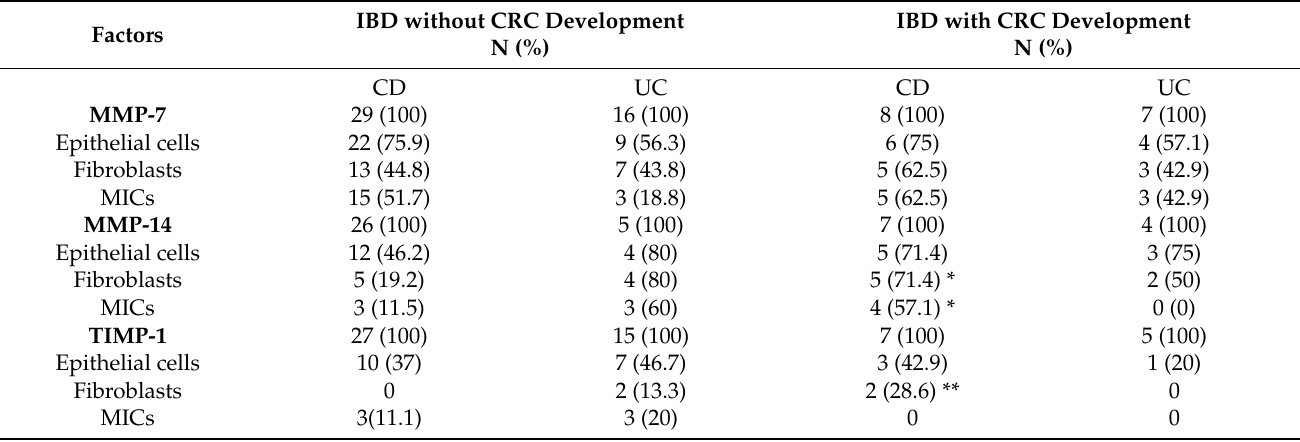
Table 4. Expression of MMP-7, MMP-14 and TIMP-1 by different cell types in inflamed tissue in IBD without or with CRC development (% of cases refers to the total number of cases analyzed indicated for each protein).